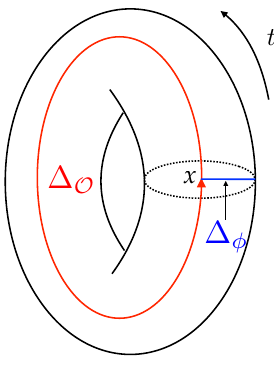
. The blue line represents the F